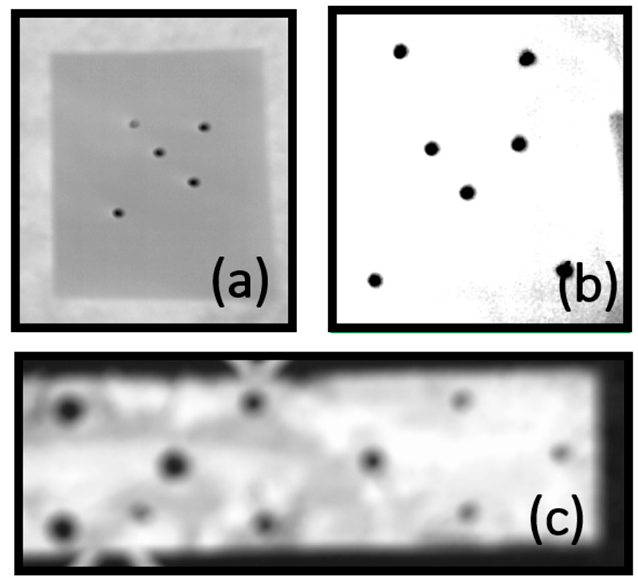
Figure 5. Passive 2D calibration tests made from various materials: ( a ) presents the visibility of low-emissivity aluminum targets on high-emissivity background (paper) in thermal image; ( b ) the visibility of low-emissivity targets (aluminum) on high-emissivity cotton fabric; ( c ) the visibility of high-emissivity targets on low-emissivity sheet aluminum in which holes of a diameter of 10, 12, and 16 mm were drilled (as a result of high reflectance coefficient of sheet metal the point targets were blurred).